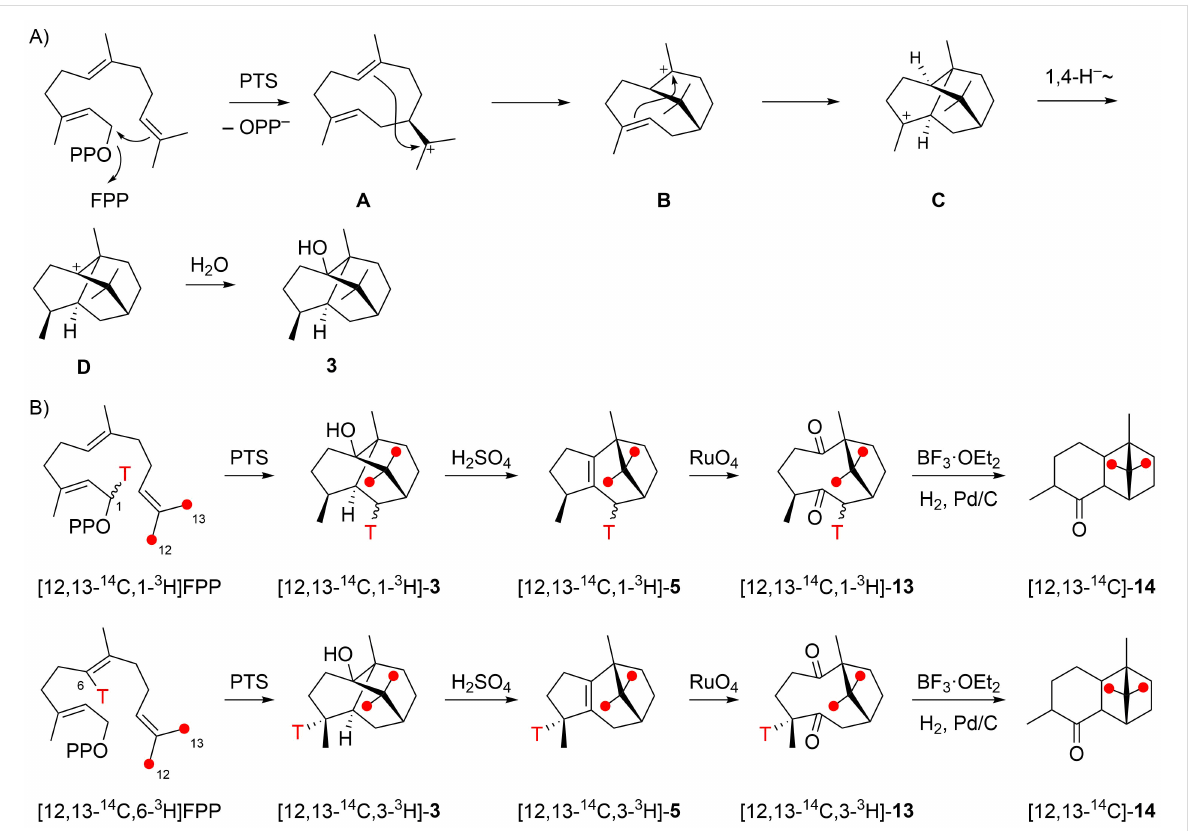
Scheme 1: Biosynthesis of patchoulol (part I). A) Cyclisation mechanism from FPP to 3 as suggested by Croteau et al., and B) labelling experiments reported in the same study [9]. For all sesquiterpenes in this study the carbon numbering follows that of FPP to indicate the (proposed) biosynthetic origin of each carbon. Red dots indicate 14 C-labelled